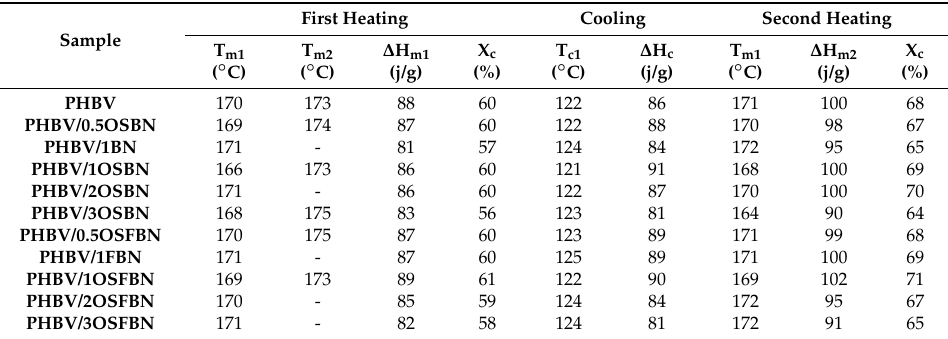
Figure 8. DSC thermograms of PHBV/BN and PHBV/FBN nanocomposites. Table 4. DSC results of nanocomposites.